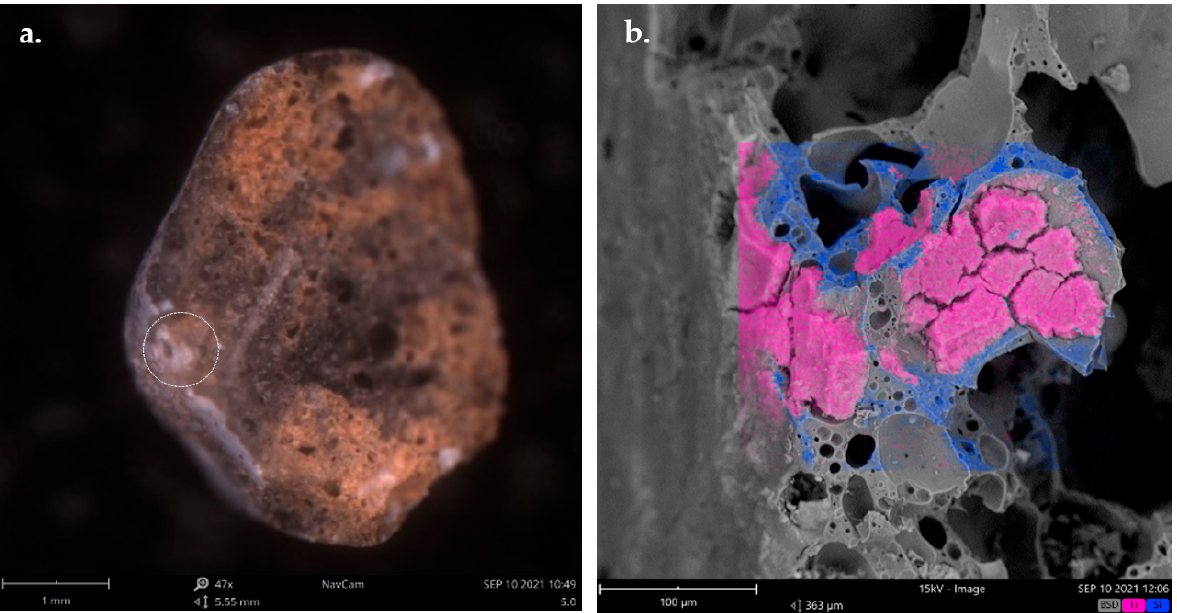
Figure 10. ( a ) Cross-section of the 5%TiO 2 /Leca photocatalyst, ( b ) mapping of a pore of the 5%TiO 2 /Leca marking Ti in pink and Si in blue.